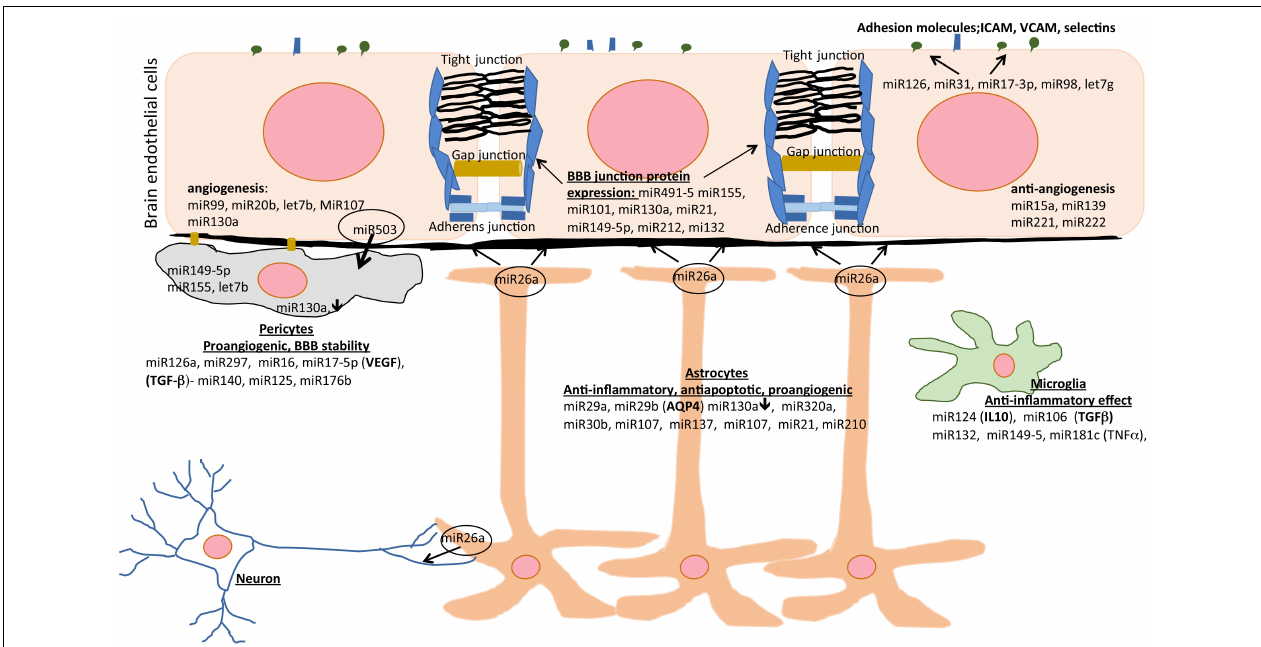
FIGURE 2 | The effects of miRs on different cell types of the NVU during post-stroke recovery. Different miRs modulate inflammation, angiogenesis, apoptosis, and blood-brain barrier (BBB) integrity and represent therapeutic area to enhance post-stroke recovery. AQP4, aquaporin-4; ICAM, intercellular adhesion molecule; IL-10, interleukin-10; TGF- β , transforming growth factor beta; VCAM, vascular cell adhesion molecule; VEGF, vascular endothelial growth